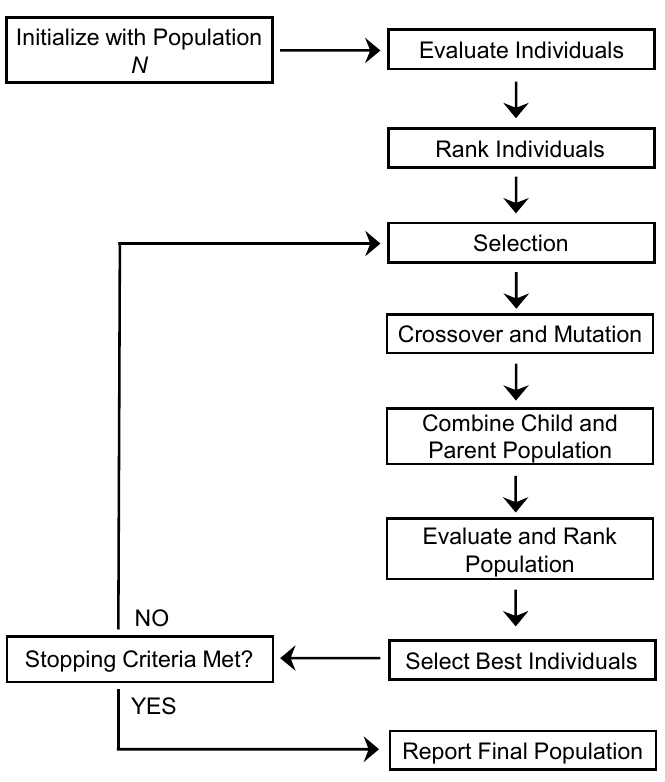
Figure 2. NSGA-II algorithm flowchart [21].